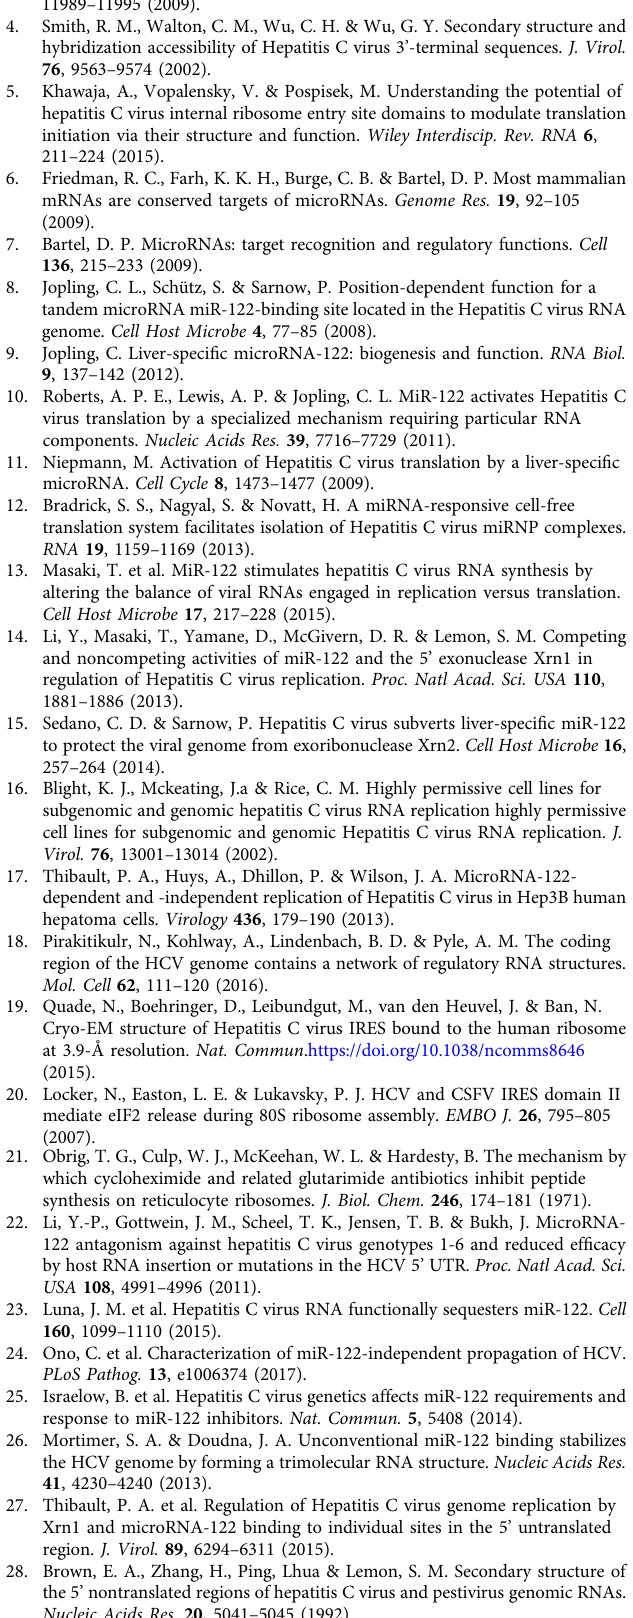
Denaturing RNA gel electrophoresis . 18S and 28S ribosomal RNA was detected for each fraction using a denaturing TAE gel approach 52 . The samples were heated to 65°C for 5min in loading buffer LDII (95% formamide, 0.025% SDS, 15mM EDTA, xylene cyanole 0.025% w/v, bromophenol blue 0.025% w/v) and fl ash cooled on ice. The denatured samples were applied to a 1% TAE agarose gel, containing 10 μg/L ethidium bromide. The gel was run for 30 min at 100V in 1× TAE buffer and bands were visualized on a UV transilluminator (INTAS). Uncropped versions of the gels can be found in Supplementary Fig. 12. Quanti fi cation and statistical analysis . Where appropriate, a paired, two-tailed Student ’ s t -test was performed using Prism 6 software (GraphPad). All data are presented as mean (±SD), the sample size is speci fi ed in the corresponding fi gure legend. P values of <0.05 were considered statistically signi fi cant. In graphs, statistical signi fi cance is indicated as follows: * P < 0.05; ** P < 0.01; *** P